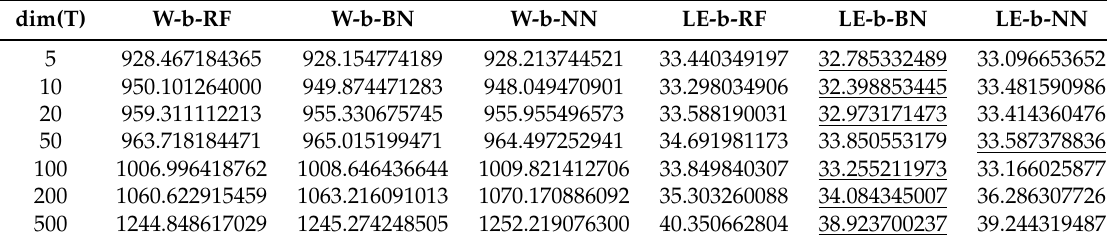
Table 8. Computational time of the feature extraction with different